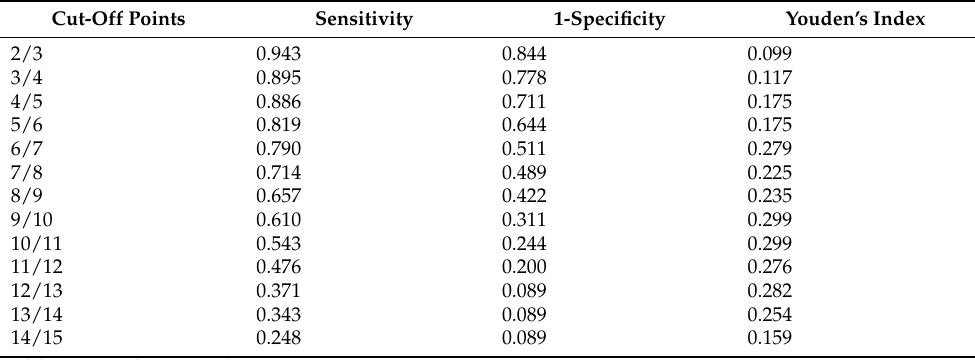
Table 4. Coordinates of the Curve of TCQ * total score with cognitive dysfunction in Group